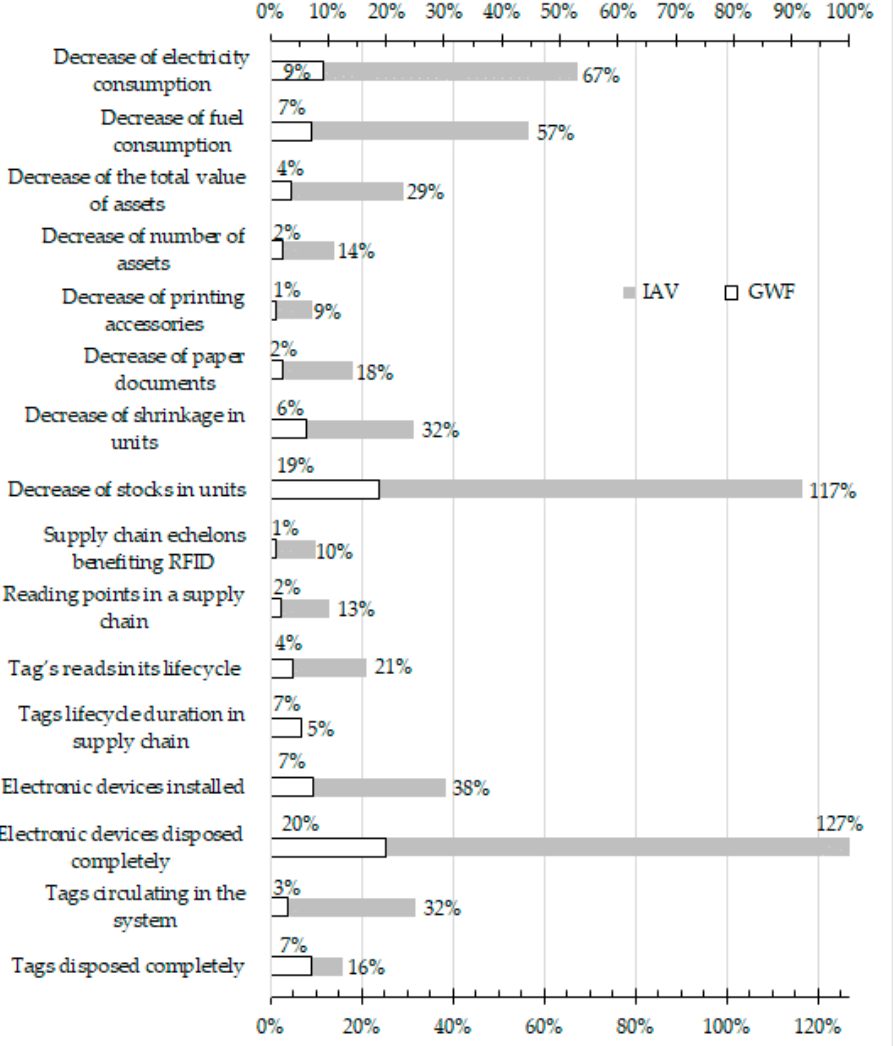
Figure 5. Impact assessment values (IAVs) and global weight factors (GWF) for the considered case.